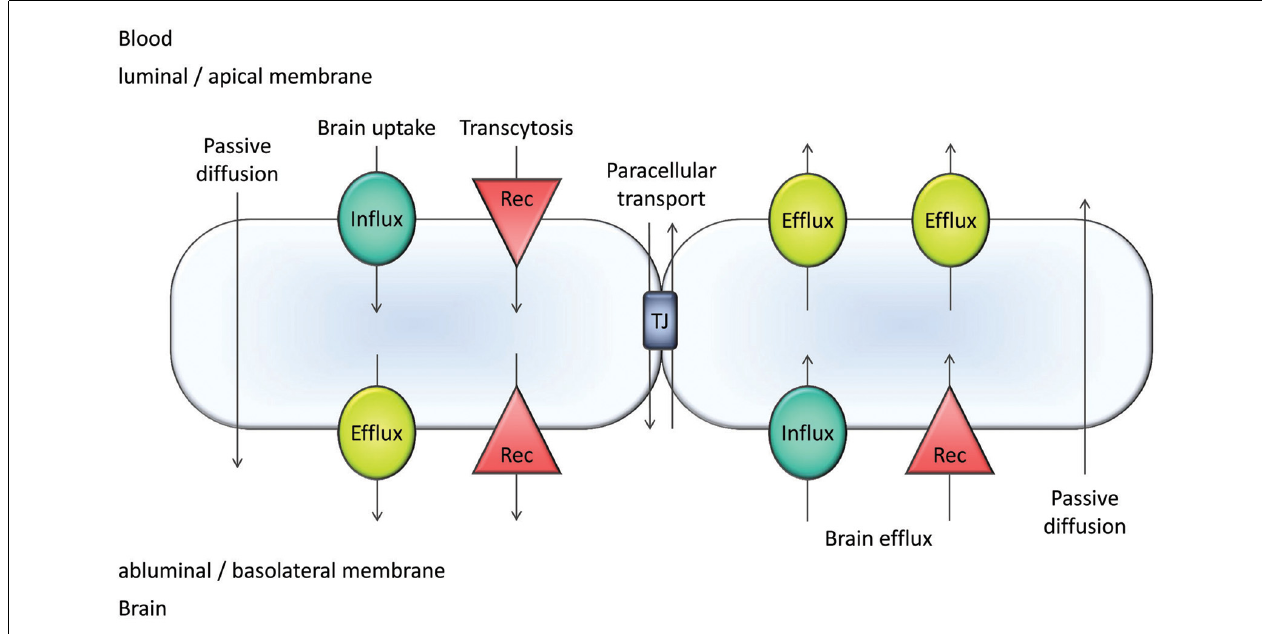
FIGURE 1 | Major transport pathways at the blood-brain barrier (BBB). Transcellular transport occurs by passive diffusion or is mediated by influx and efflux transporters/carriers and/or receptors (Rec). Passive diffusion can be bidirectional; however, it is most often a blood-to-brain transport utilized by intermediate/high passive-permeability drugs. Paracellular transport is only significant for small compounds (MW < 250